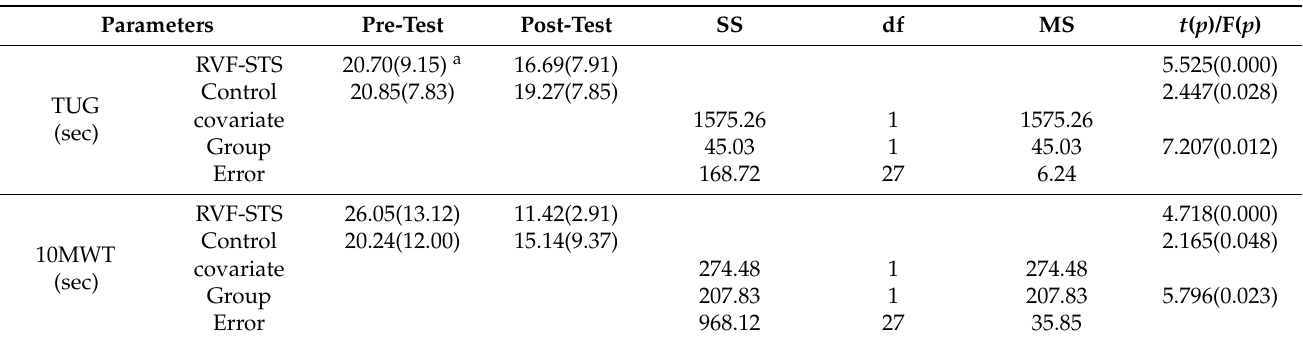
Table 5. Comparison of gait ( N = 30).